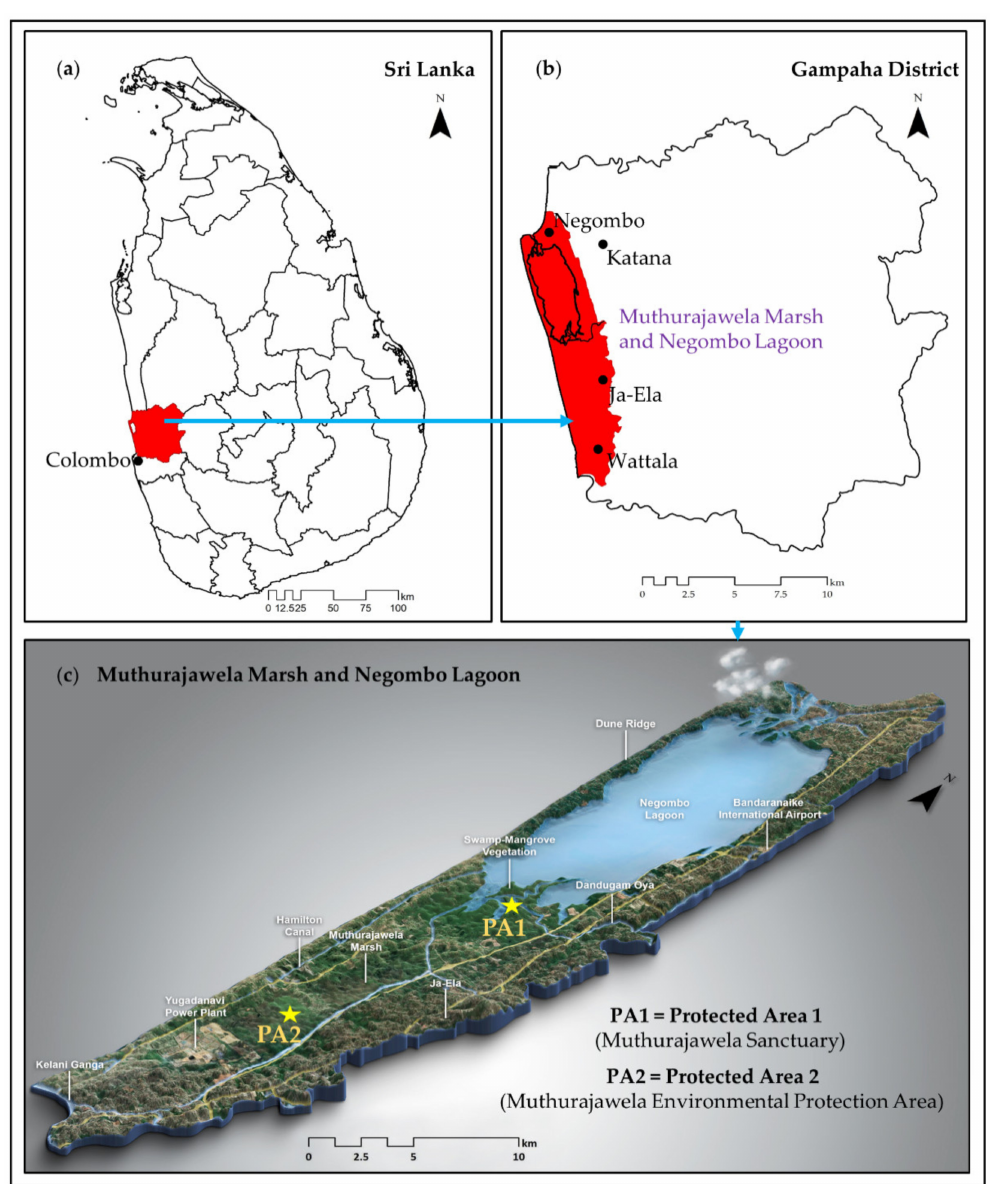
Figure 2. Location of the MMNL. ( a ) Map of Sri Lanka, ( b ) Gampaha District, and ( c ) a 3D map of the MMNL produced using a 30 m digital elevation model (ASTER). The Google Earth image was acquired on 17 February